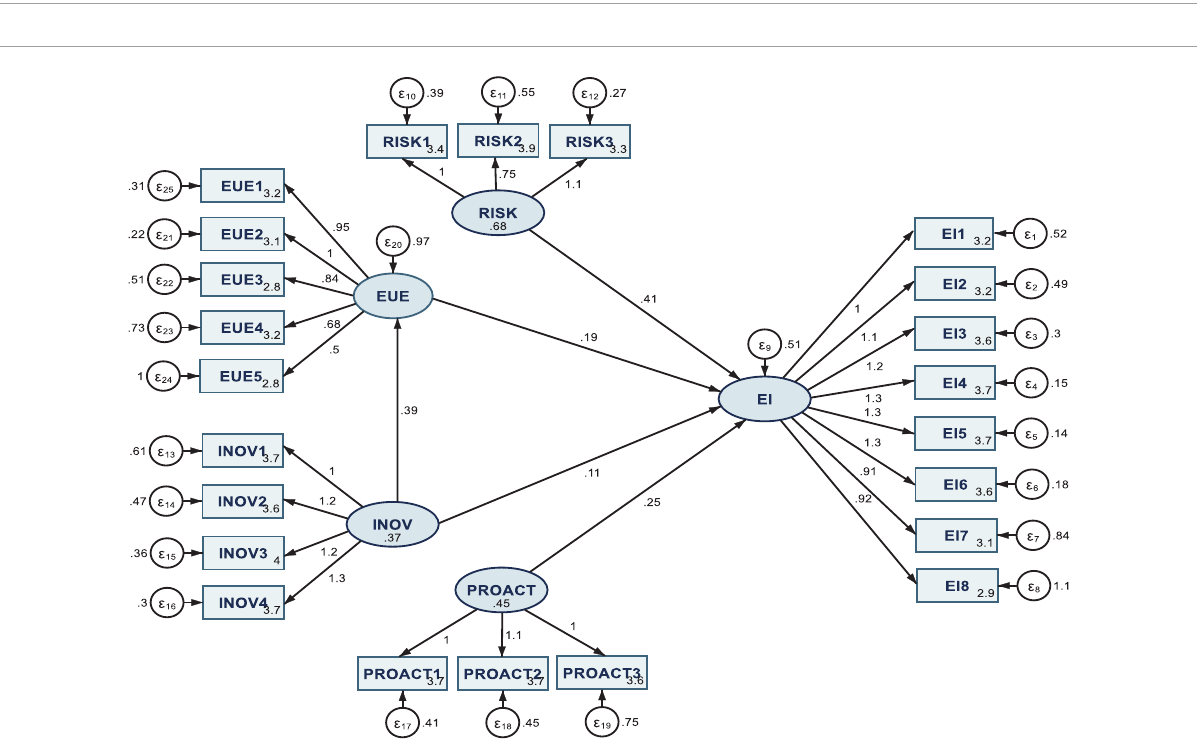
FIGURE3 Results of SEM 2 model processed on the sub-sample acknowledging COVID-19 modelers and influence on the entrepreneurial intention. Authors’ research in Stata